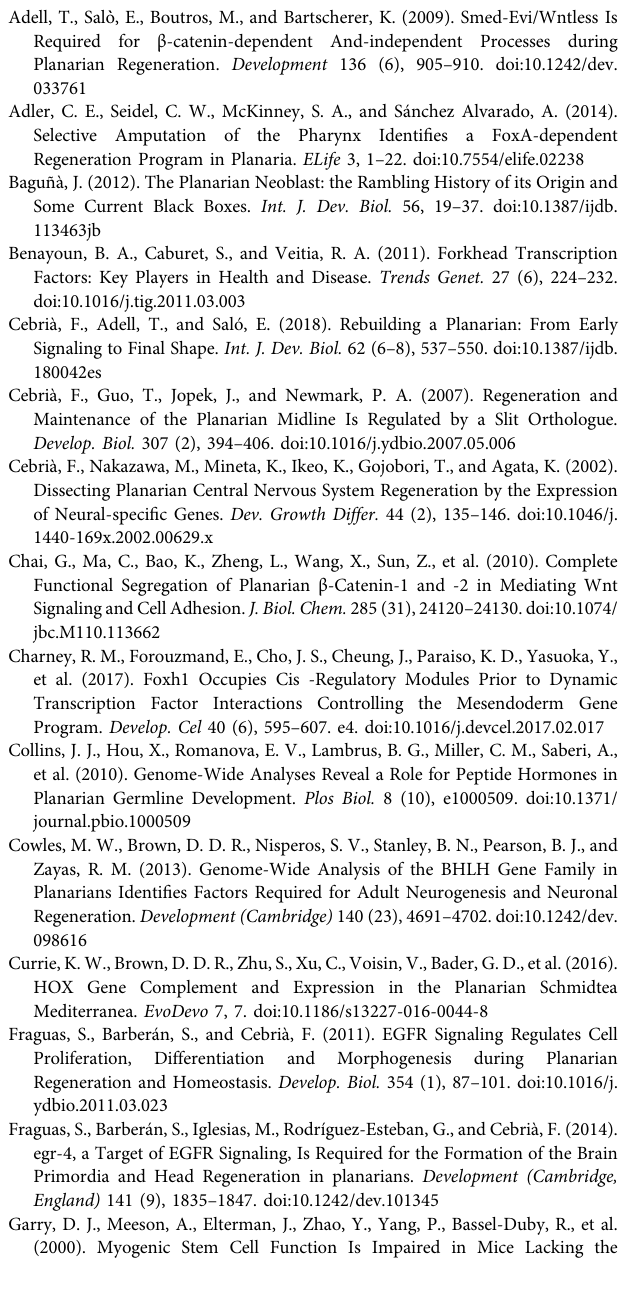
schematic planarians, red lines indicate the amputation planes and black squares the region analysed. Supplementary Figure S2 | Expression pattern of tissue-speci fi c markers in foxK1 RNAi planarians. (A ) Whole-mount in situ hybridization of the neural marker sim